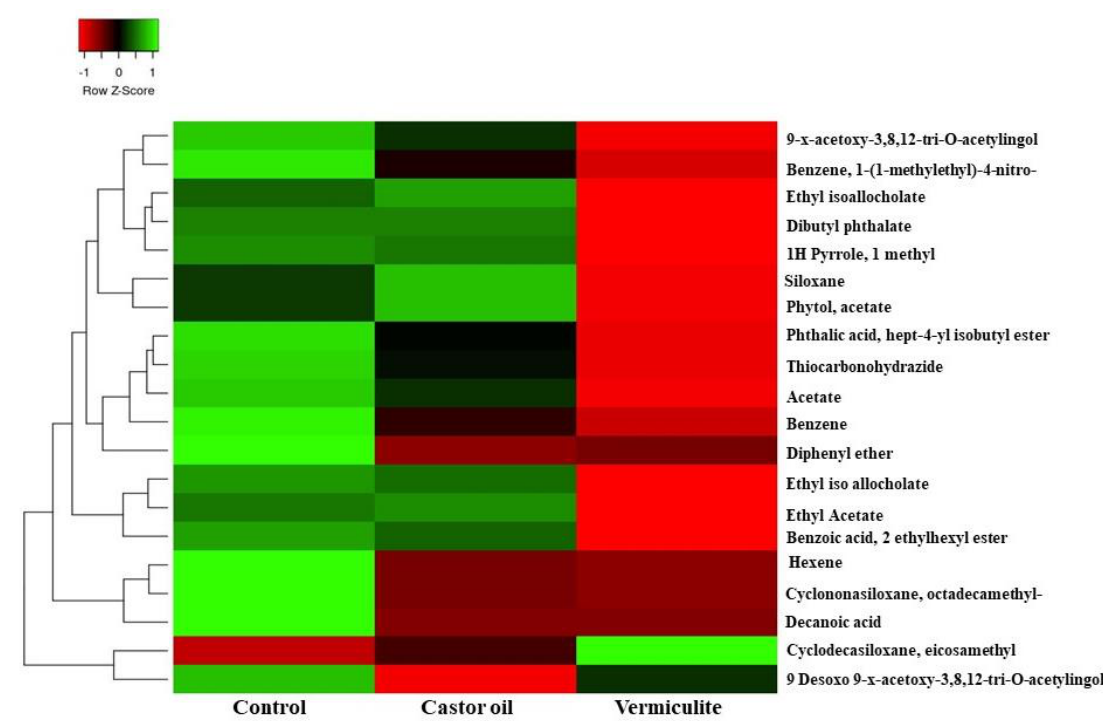
Figure 1. Comparative analysis of VOCs produced by vermiculite and castor oil.